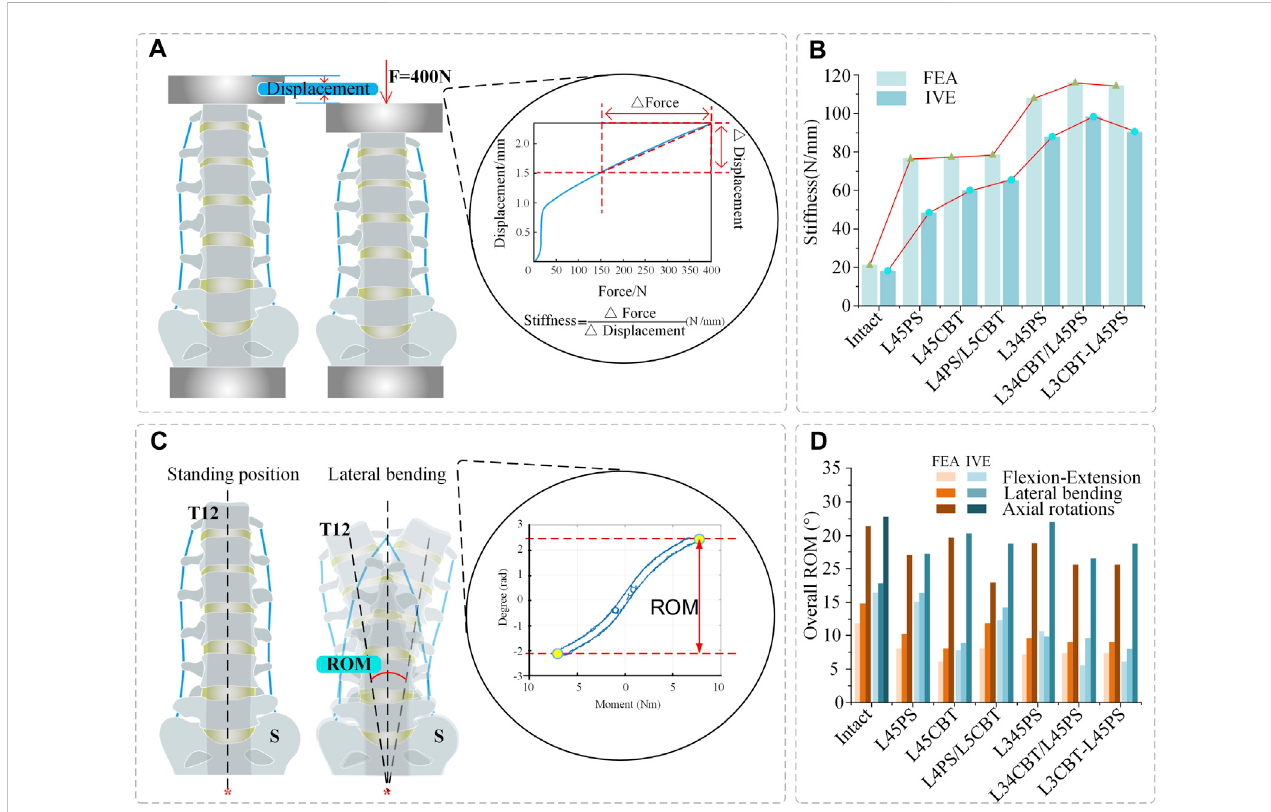
FIGURE 5 Stiffness and overall ROM. (A) Stiffness calculation (force – displacement curve). (B) Comparison of stiffness, between FEMs and IVEs under different conditions. (C) ROM measurement. (D) Comparison of overall ROM, between FEMs and IVEs under different